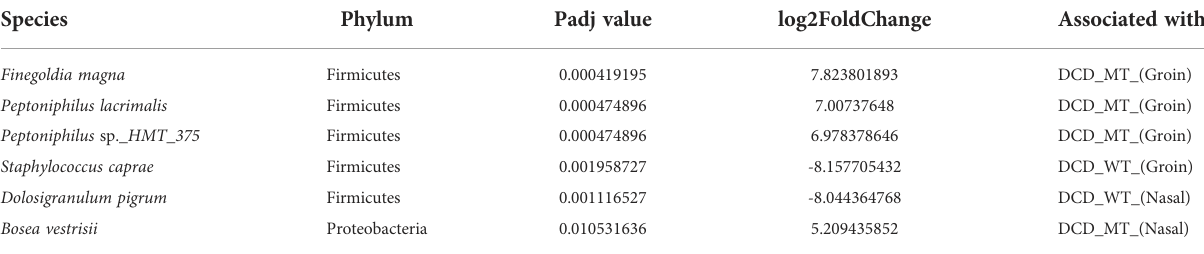
TABLE 1 Identi fi ed differential abundant taxa (adjusted P value <0.05) when comparing groin and nasal microbiomes of DCD_MT study population versus healthy controls (DCD_WT) using